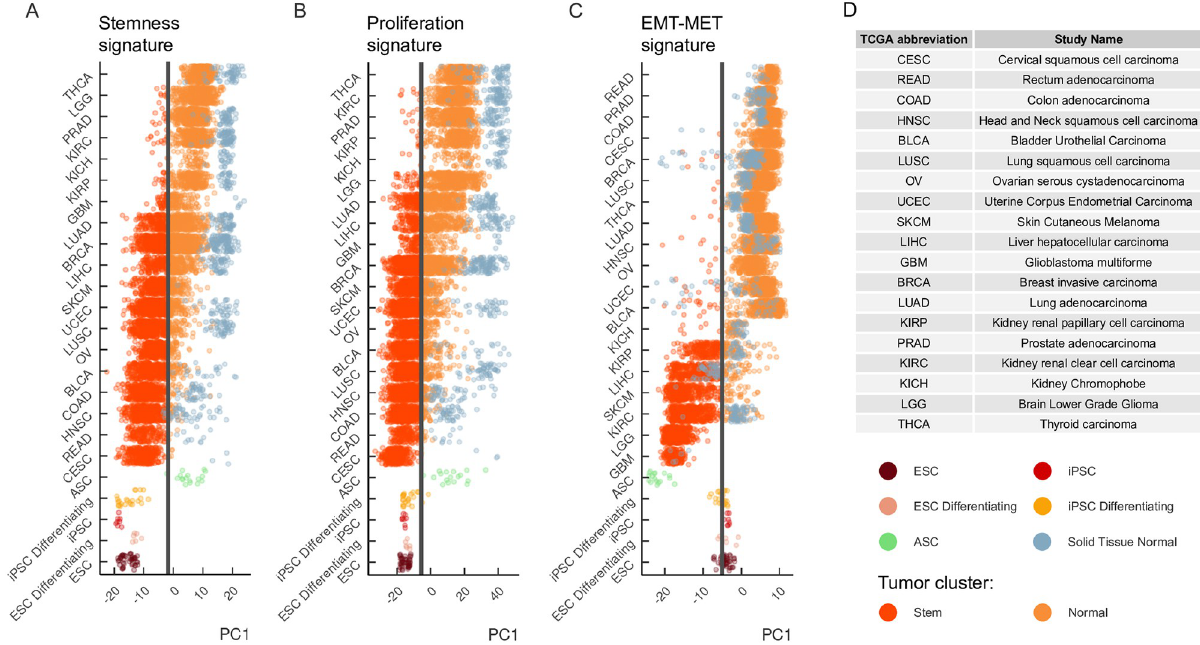
Fig 3. Heterogeneity of stemness and proliferation signatures across tumor types. The first principal component (PC1) encodes the signature of stemness (A), proliferation (B), and EMT-MET signature genes (C). The samples are plotted separately for each tumor in the TCGA project, normal tissues, and iPSCs. Tumor samples are colored according to their position relative to the PC1 median (black vertical line). Tumor samples located to the right (left) of the median are assigned to the Normal (Stem) cluster, respectively. (D) The standard TCGA notation for cancer types.